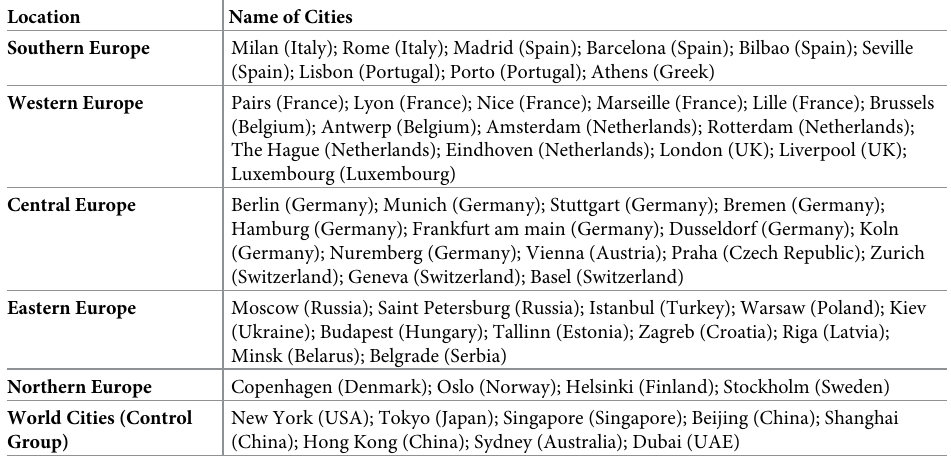
Table 1. City list of the research